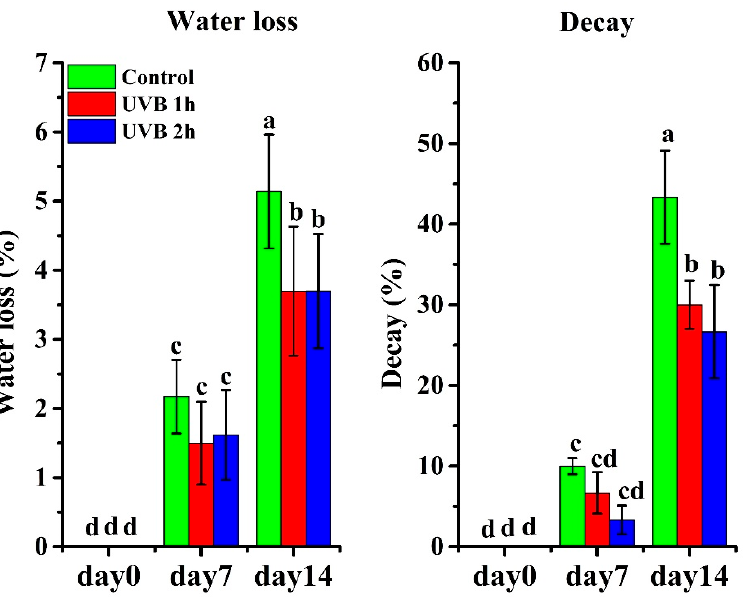
Figure 4. Effects of UV-B treatment on water loss and decay incidence of strawberry fruits. The data are based on ten biological replicates. * p < 0.05.